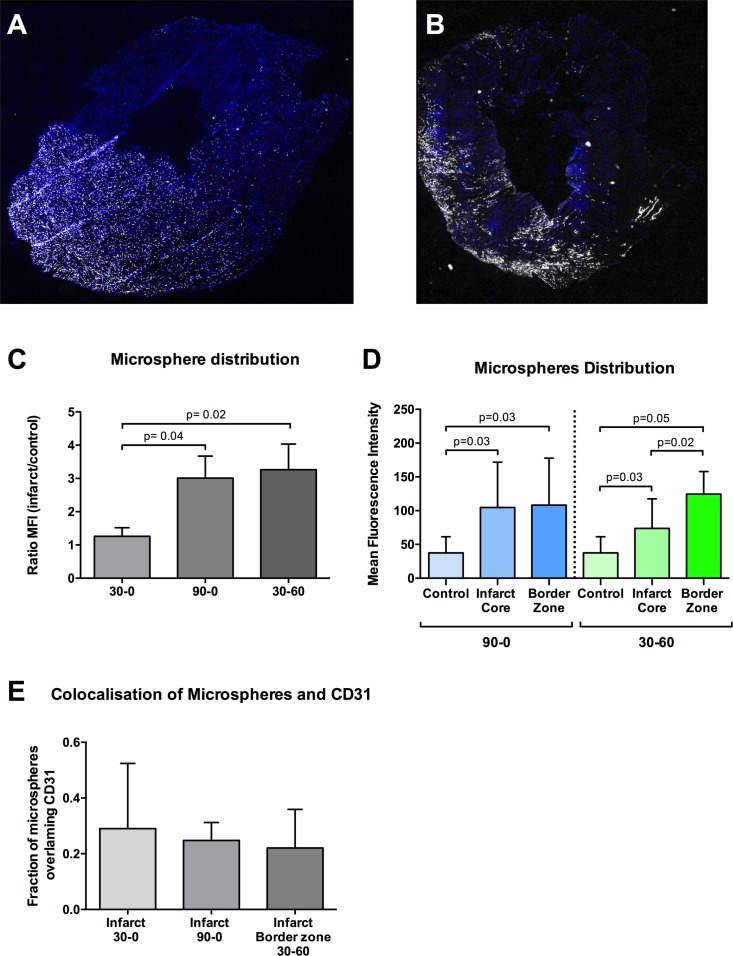
Distribution of fluorescent microspheres.A-B Images of transverse slices of the left ventricle, showing distribution of fluorescent microspheres (white). Nuclei are stained with Hoechst (blue). Red arrow: infarct zone, asterisk: control zone. A-B represents group 90–0 and 30–60 respectively. White bars represent 1mm. C Distribution of MFI within the 90–0 and 30–60 group D Mean fluorescent intensity (MFI) of fluorescent microspheres, expressed a ratio between infarct area and control area. E Pixel-based colocalisation analysis of fluorescent microspheres and CD31 positive tissue for extravasation.